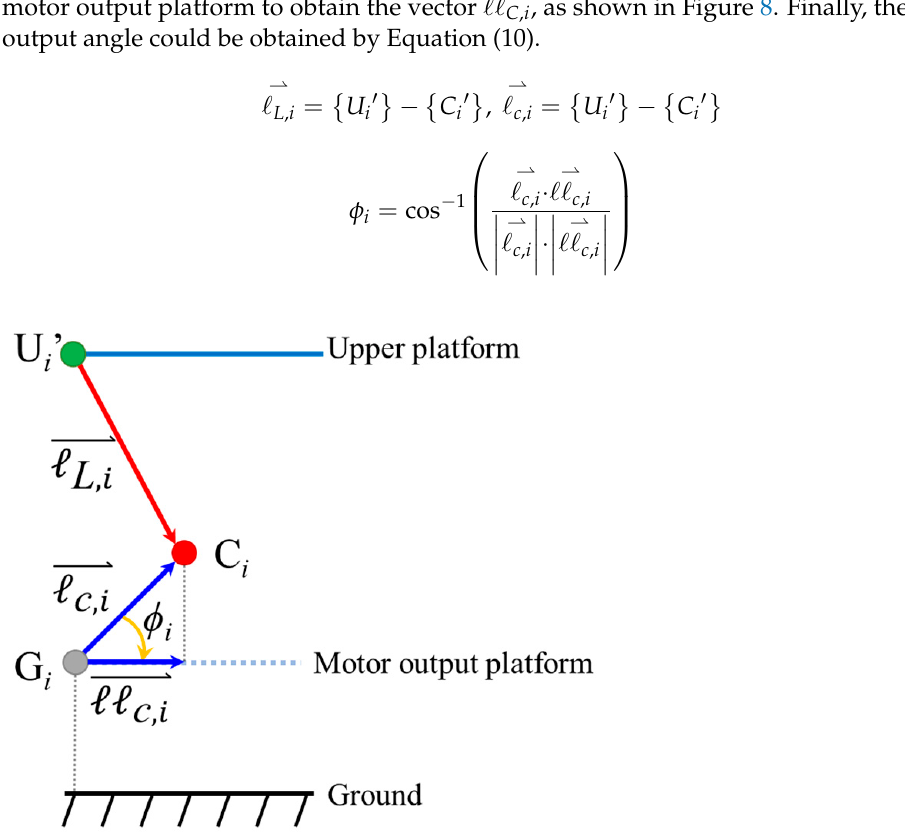
Figure 8. Vector